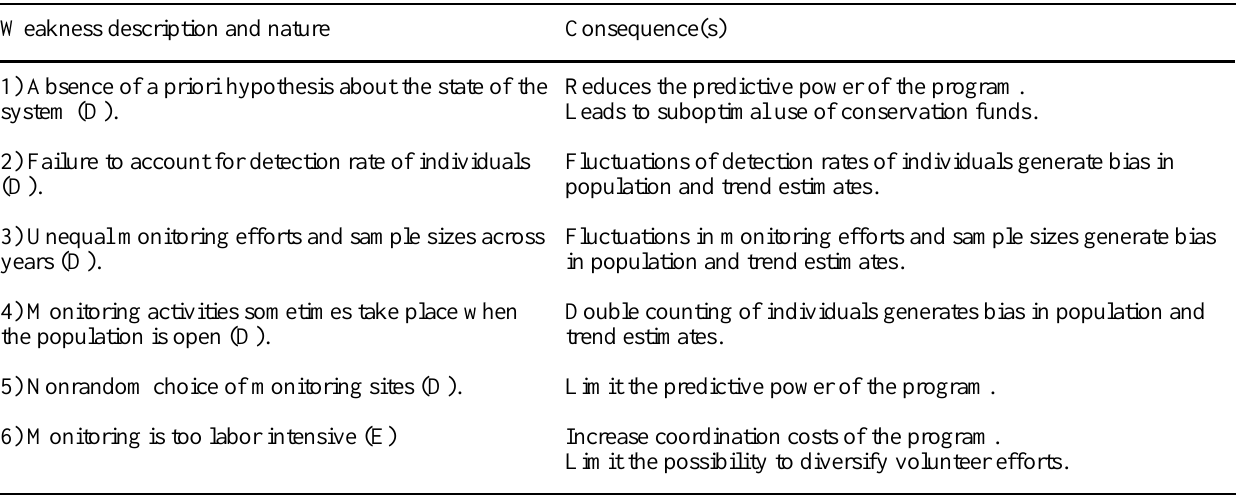
Table 1. Weaknesses of the Québec Chimney Swift Monitoring Program and their respective consequences. The letters in parentheses specify if the weakness is related to a design (D) or efficiency (E)